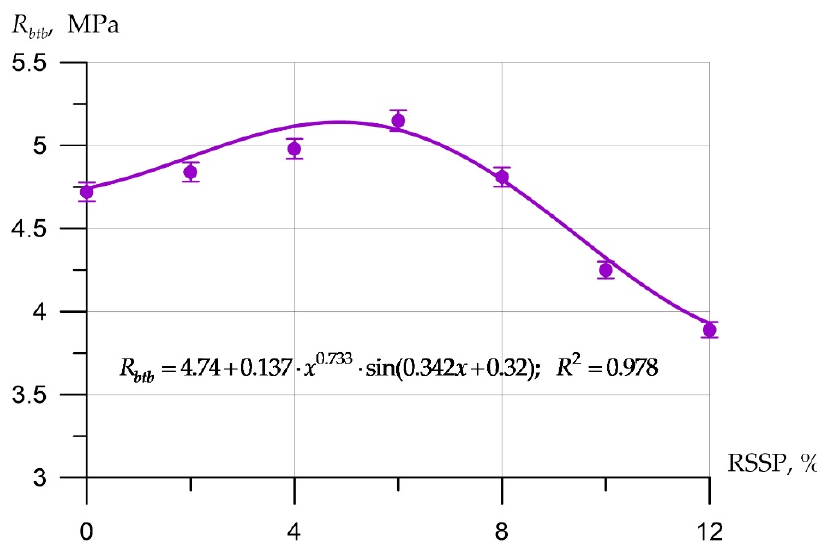
Figure 6. Tensile strength in bending of snail shell powder concrete.